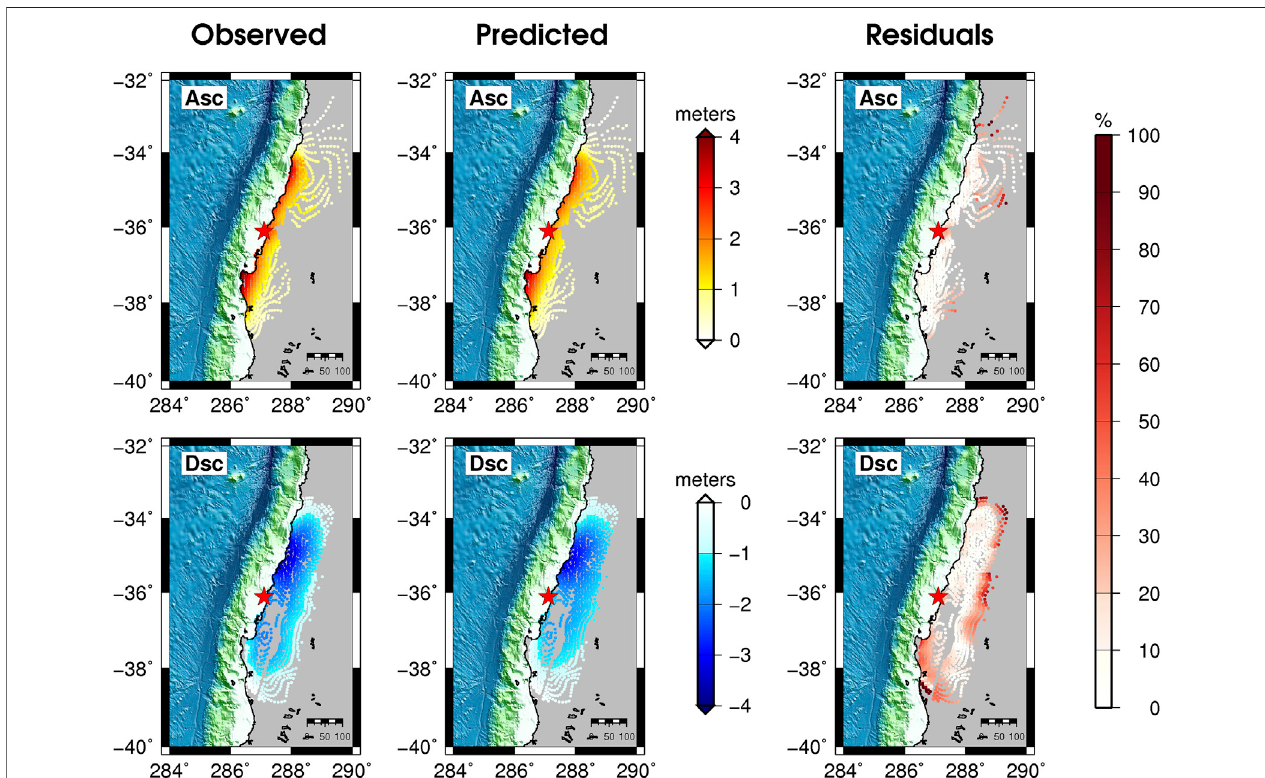
FIGURE 8 | Comparison between observed, predicted, and percentage residuals of ascending ( upper panels ) and descending ( bottom panels ) InSAR data for the slip distribution obtained by jointly inverting geodetic and tsunami data using OTA ( Figure 6 ).